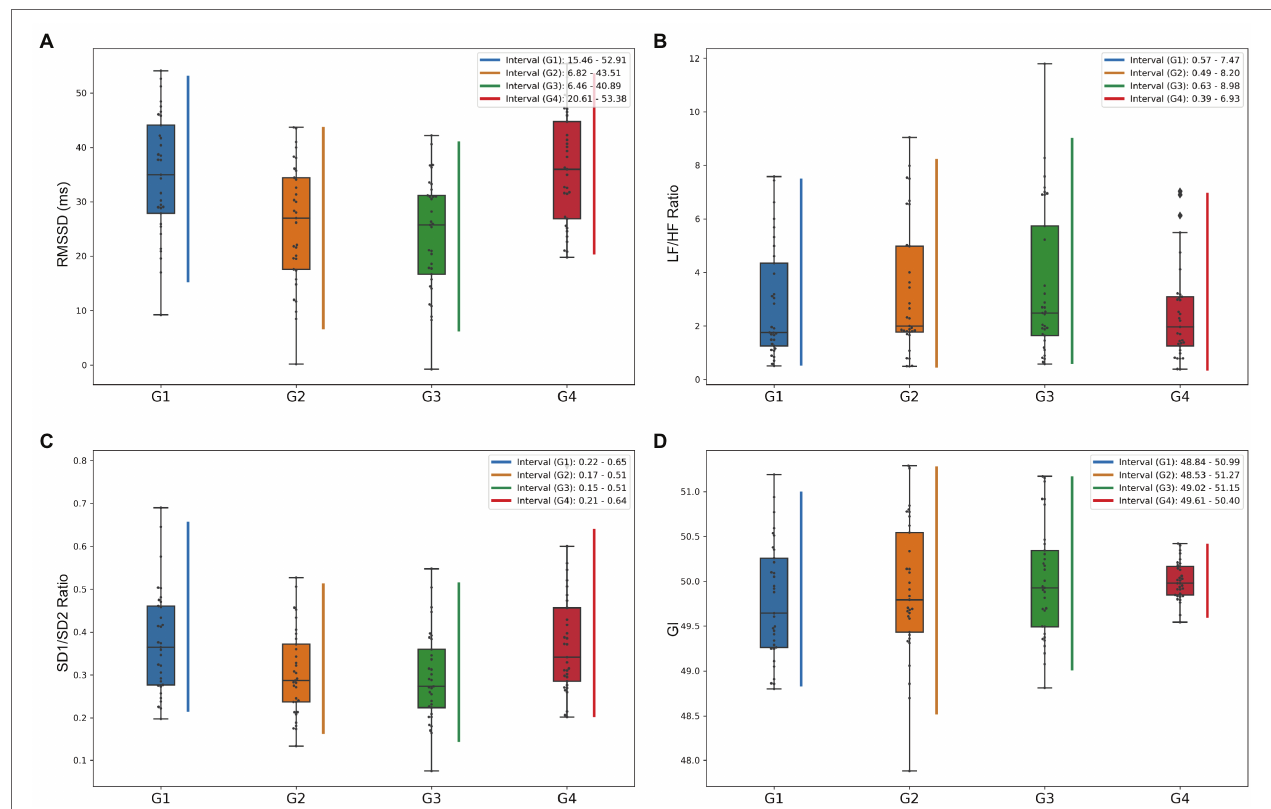
FIGURE 2 | Box plots of heart rate variability (HRV) metrics to show the variation of data distribution by longitudinal grouping. (A–D) Shows box plots of the distributions of RMSSD, LF/HF ratio, SD1/SD2 ratio, and GI indices, respectively, and the vertical lines represent the central 95% intervals of the distributions of each